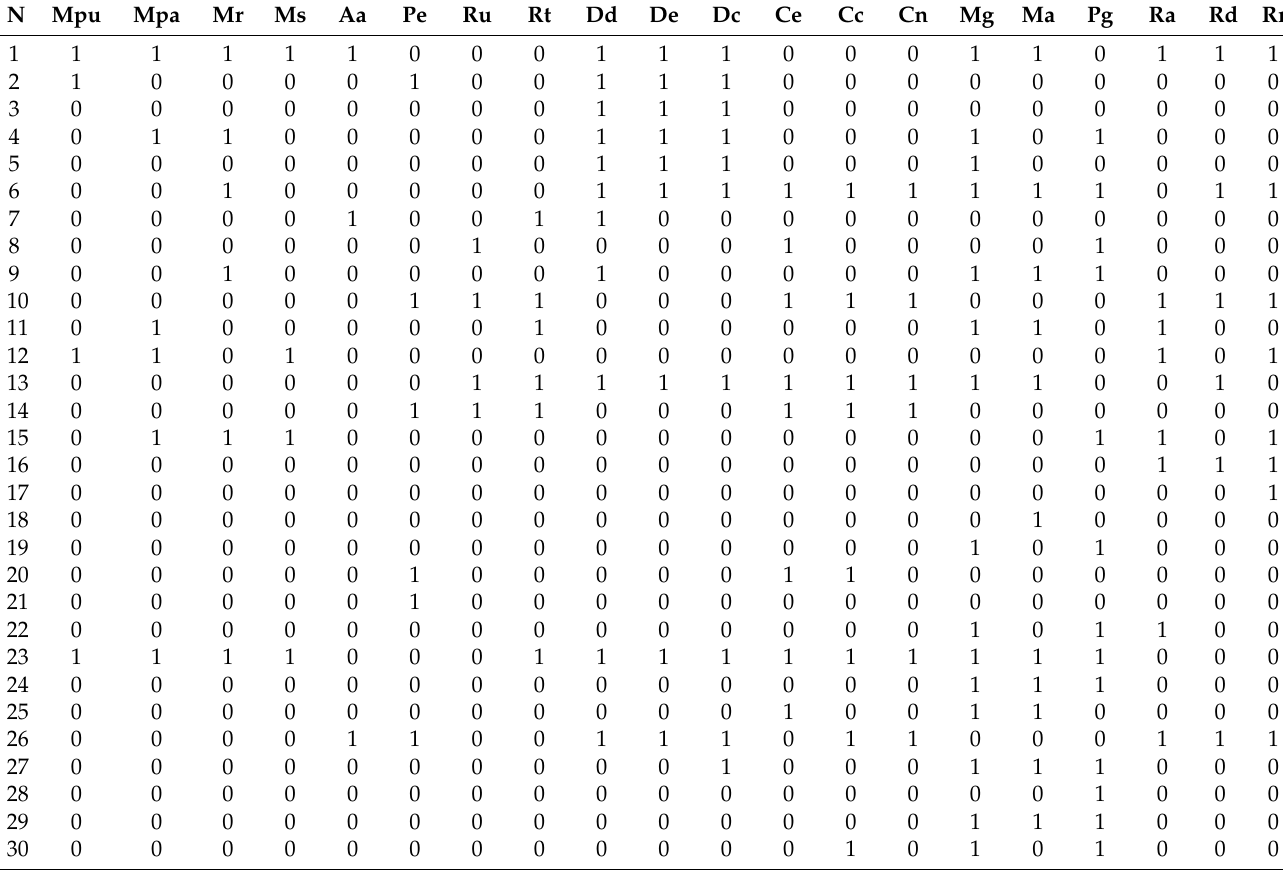
Table 2. Craniodental and antler characteristics used in the hierarchical clustering. Abbreviations: N, number of morpholog- ical character (see explications in the research methods description); Mpu, Metacervocerus punjabiensis ; Mpa, Metacervocerus pardinensis ; Mr, Metacervocerus rhenanus ; Ms, Metacervocerus shansius ; Aa, Axis axis ; Pe, Panolia eldii ; Ru, Rusa unicolor ; Rt, Rusa timorensis ; Dd, Dama dama ; De, Dama eurygonos ; Dc, Dama clactoniana ; Ce, Cervus elaphus ; Cc, Cervus canadensis ; Cn, Cervus nippon ; Mg, Megaloceros giganteus ; Ma, Megaceroides algericus ; Pg, Praedama giulii ; Ra, Rucervus ardei ; Rd, Rucervus duvaucelii ; Rr, Rucervus radulescui